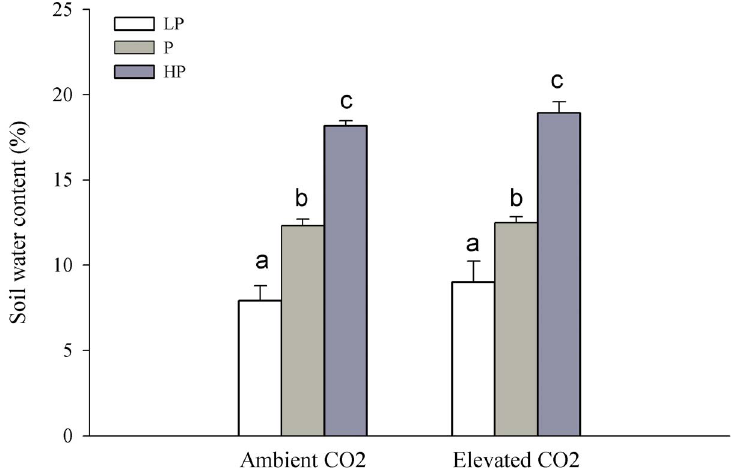
Figure 3. Effect of precipitation on soil water content under two CO 2 concentrations. LP, P, HP represents low precipitation ( 2 40%), normal precipitation and high precipitation ( + 40%), respectively. Different letters indicate a significance difference among levels of precipitation ( P , 0.05).